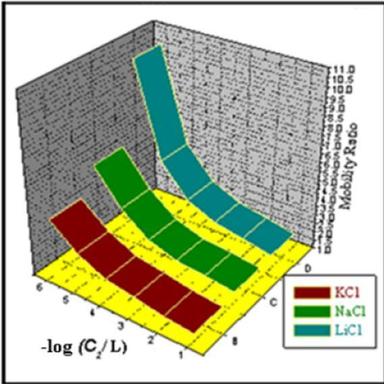
The plot of mobility ratio against logarithm of concentration of PVC–NP composite membrane.